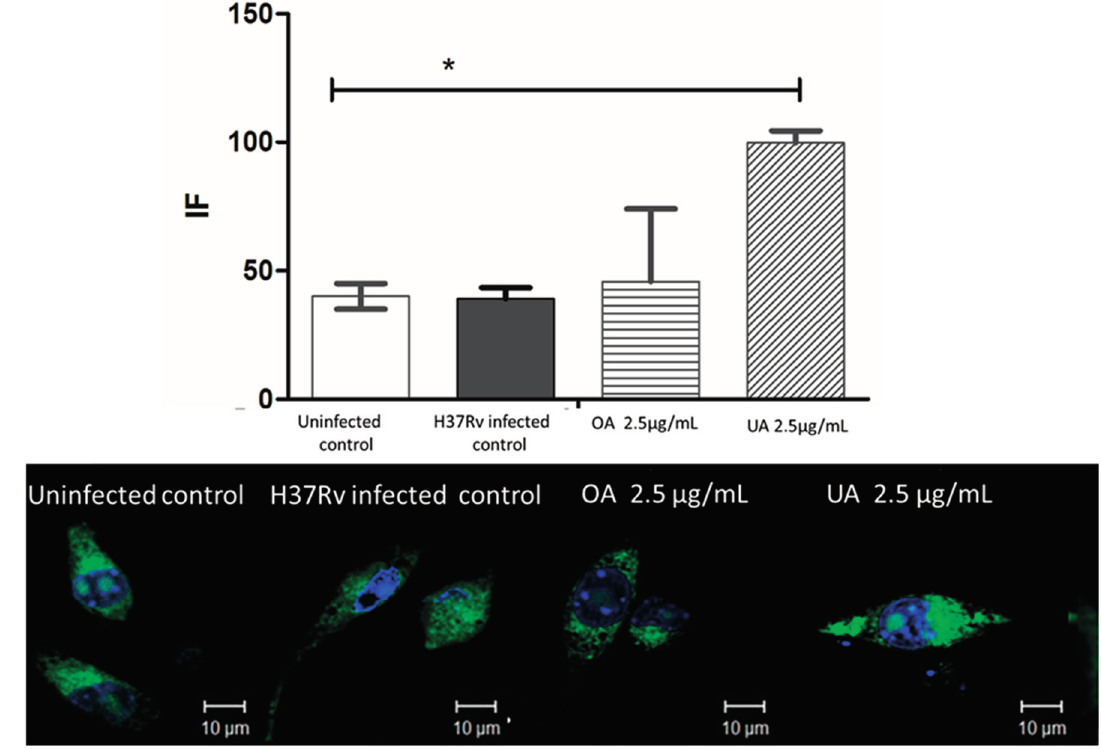
Figure 7. CD 36 expression on macrophages infected with MTB H37Rv and treated with OA and UA. Macrophages were infected for 2 h with MTB and then treated with 2.5 µg/mL of each triterpene. Cells were stained with anti CD36, and nuclei were stained with DAPI. Upper panel: Mean fluorescence intensity (IF) was determined in LSM Pascal V 5.1 software (Zeiss, Heidelberg, Germany). Lower panel: Representative confocal images of control macrophages (Uninfected control), infected macrophages (H37Rv infected control), infected macrophages treated with OA (OA 2.5 µg/mL) and infected macrophages treated with UA (UA 2.5 µg/mL). Green label corresponds to CD36 receptor and blue label to nuclei. Statistically significant differences are indicated (* p <